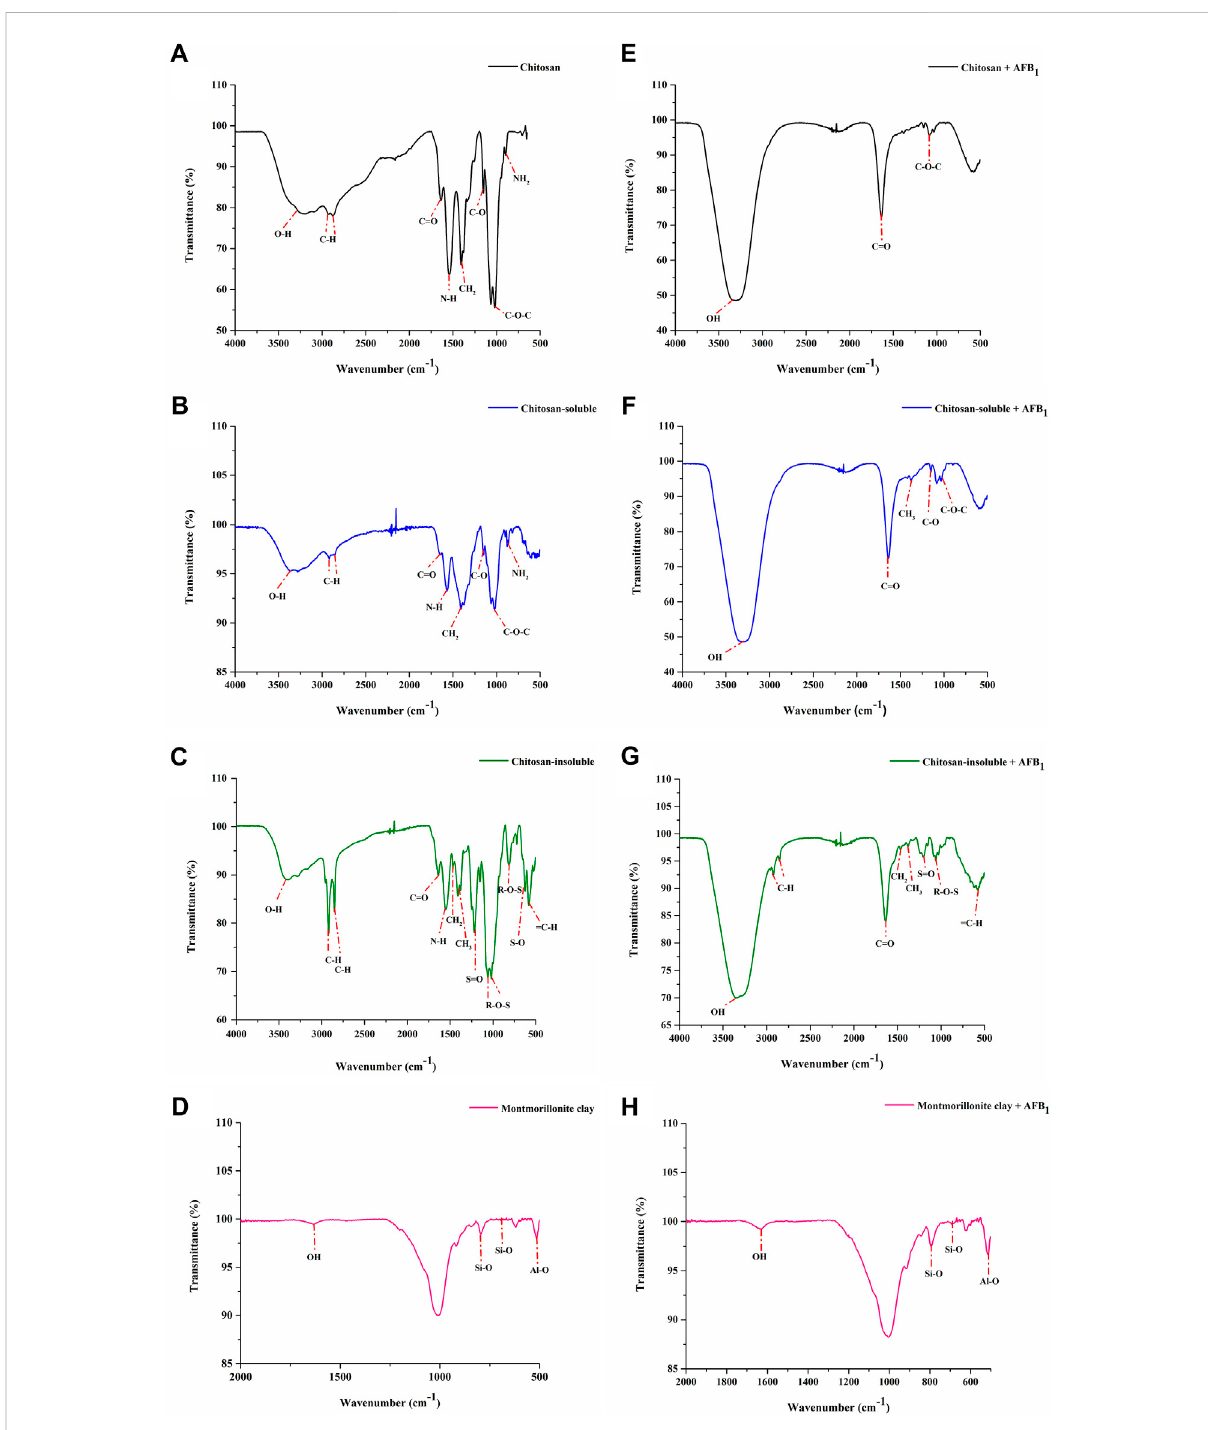
FIGURE 1 FTIR spectra: (A) chitosan, (B) chitosan-soluble, (C) chitosan-insoluble, (D) montmorillonite clay, and the interaction of AFB 1 with chitosan (E) , with chitosan-soluble (F) , with chitosan-insoluble (G) , and with montmorillonite clay (H) .